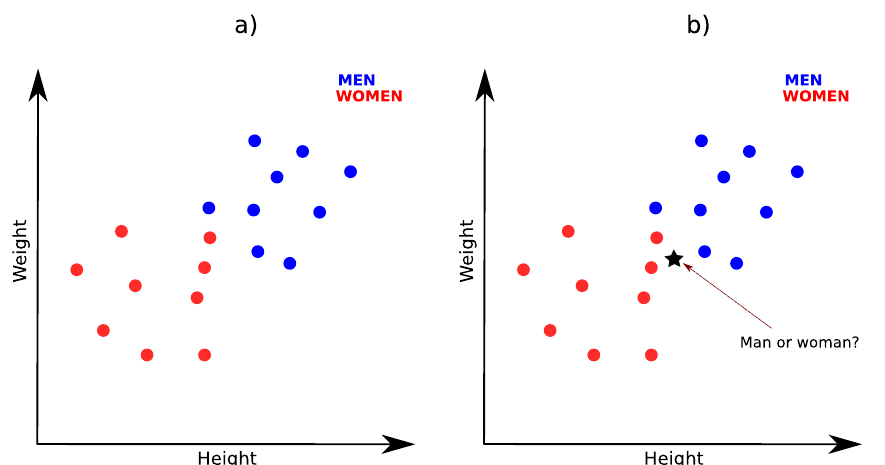
Figure 1. ( a ) Men and women distribution according to height and weight. ( b ) New observation added to the